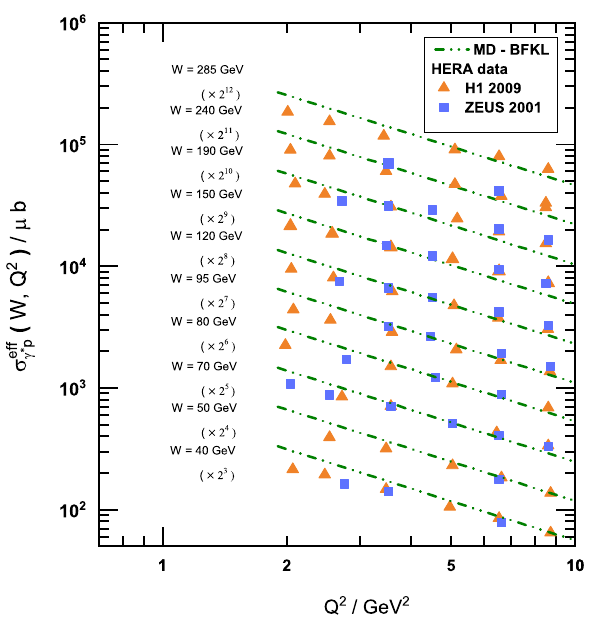
Fig. 18 QCD prediction from KC improved MD-BFKL for virtual photon–proton cross section σ eff γ ∗ as a function of Q 2 at different values p of W . The cross section for different W values are multiplied by factor multiple of 2 indicated in the figure. The included data are from H1 [59] √ √ s = 318 GeV) and ZEUS [64] ( s = 300 (